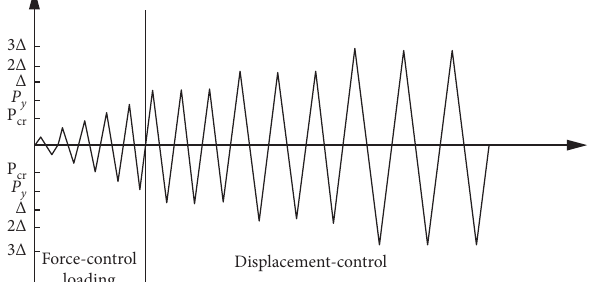
Figure 3: Test setup.